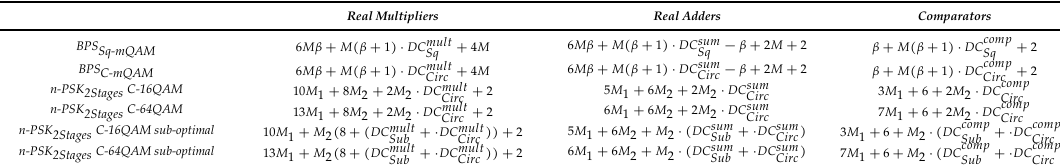
Table 1. Computational complexity of various CPR algorithms.